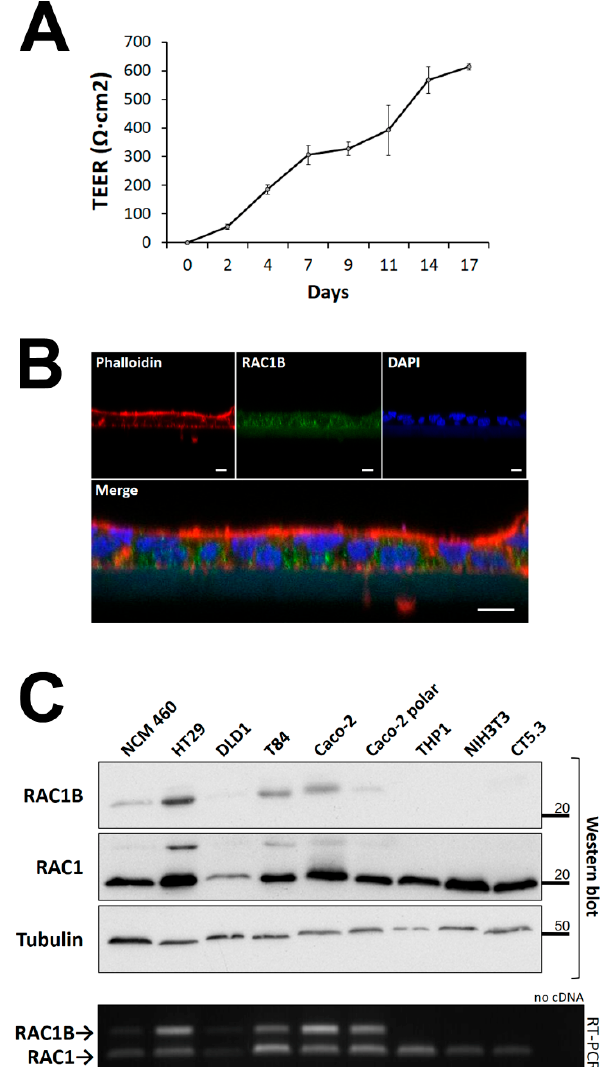
Figure 1. Characterization of RAC1B expression in colorectal cells. ( A ) Caco-2 cells were seeded on filter inserts for the formation of a polarized cell layer and polarization progress was monitored by TEER measurement with a Chopstick Electrode STX2, for up to seventeen days. ( B ) Caco-2 cell polarization and RAC1B localization were analysed by confocal immunofluorescence microscopy at day 14 of culture. Merge is the overlay of three confocal immunofluorescence images, with cell nuclei in blue (DAPI), endogenous RAC1B protein in green, and the actin filament marker phalloidin in red; scale bar = 10 μ m. ( C ) Expression of RAC1B and RAC1 protein (Western blot) and mRNA (RT-PCR) in whole cell lysates from colon and stromal cell lines. Proteins were separated by SDS-PAGE and the indicated proteins detected by WB with alpha-Tubulin used as a loading control. Migration position of molecular weight markers is indicated in kDa. Note that the anti-RAC1 antibody also stains RAC1B as a weak band of higher molecular weight. Below, the ethidium bromide-stained agarose gel shows the corresponding amplification of the two RAC1 gene-derived transcripts of 238 and 181 bp,